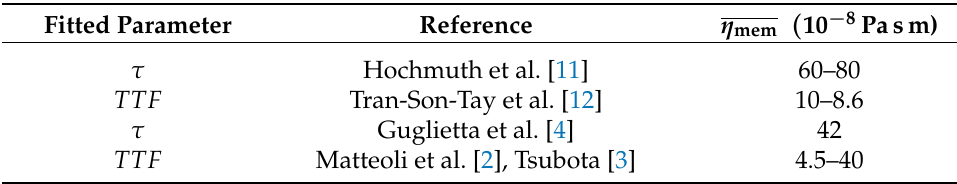
Table 2. Comparison of the η mem values from different